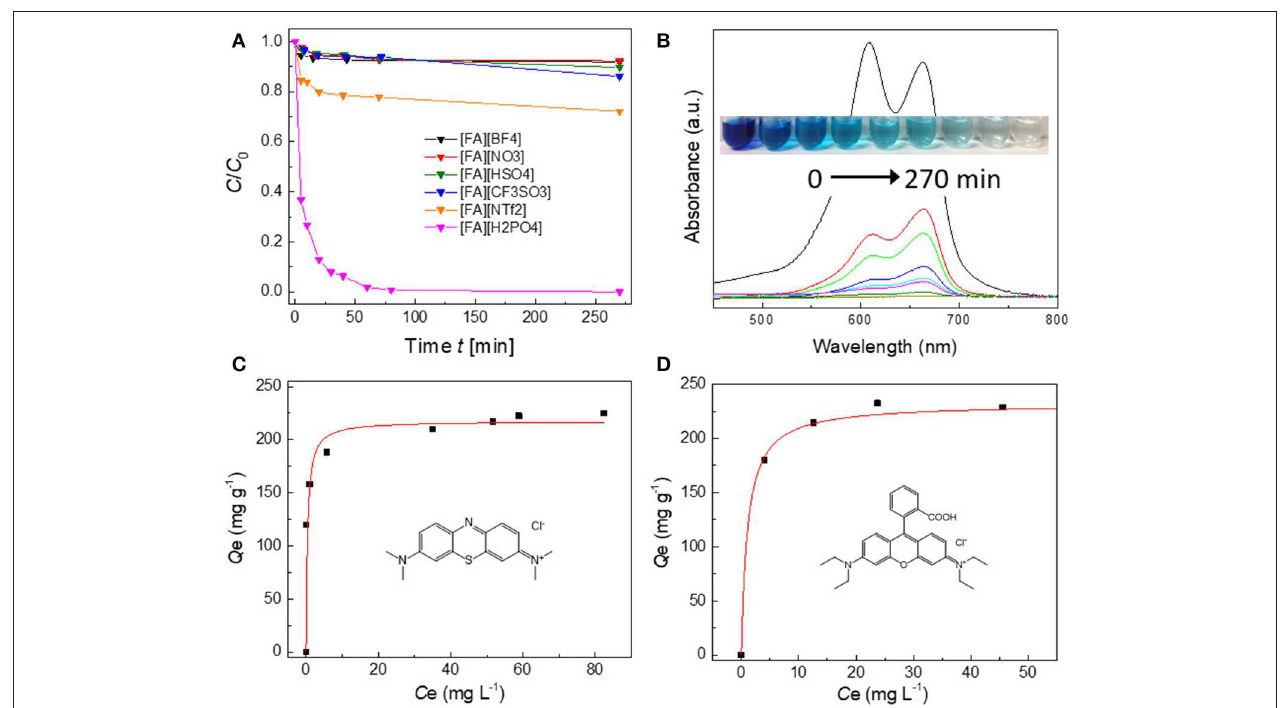
FIGURE 8 | (A) Adsorption rates of MB on various porous carbons derived from [FA][X] (80mg L − 1 , 20mL, 10mg carbon). (B) UV–vis absorption spectra and corresponding photograph (inset) of the MB aqueous solutions in the presence of [FA][H 2 PO 4 ]-derived carbon at different intervals. (C,D) Adsorption isotherms of MB and RhB on [FA][H 2 PO 4 ]-derived porous carbon, respectively. The insets show the molecular structures of MB and RhB,